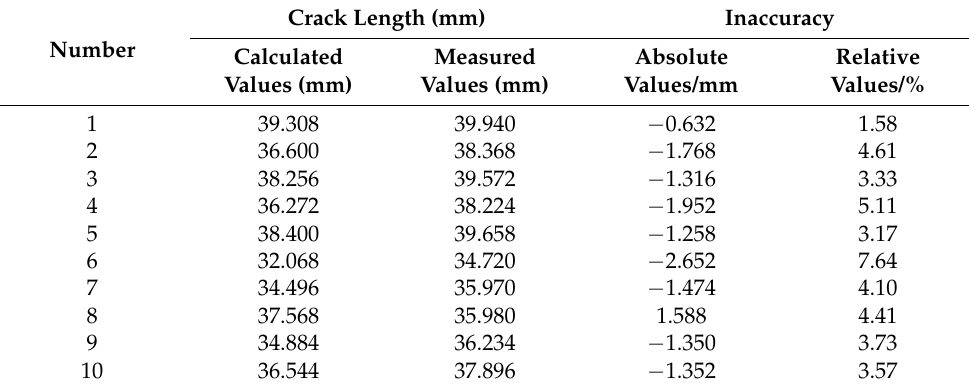
Table 5. Comparison of crack length